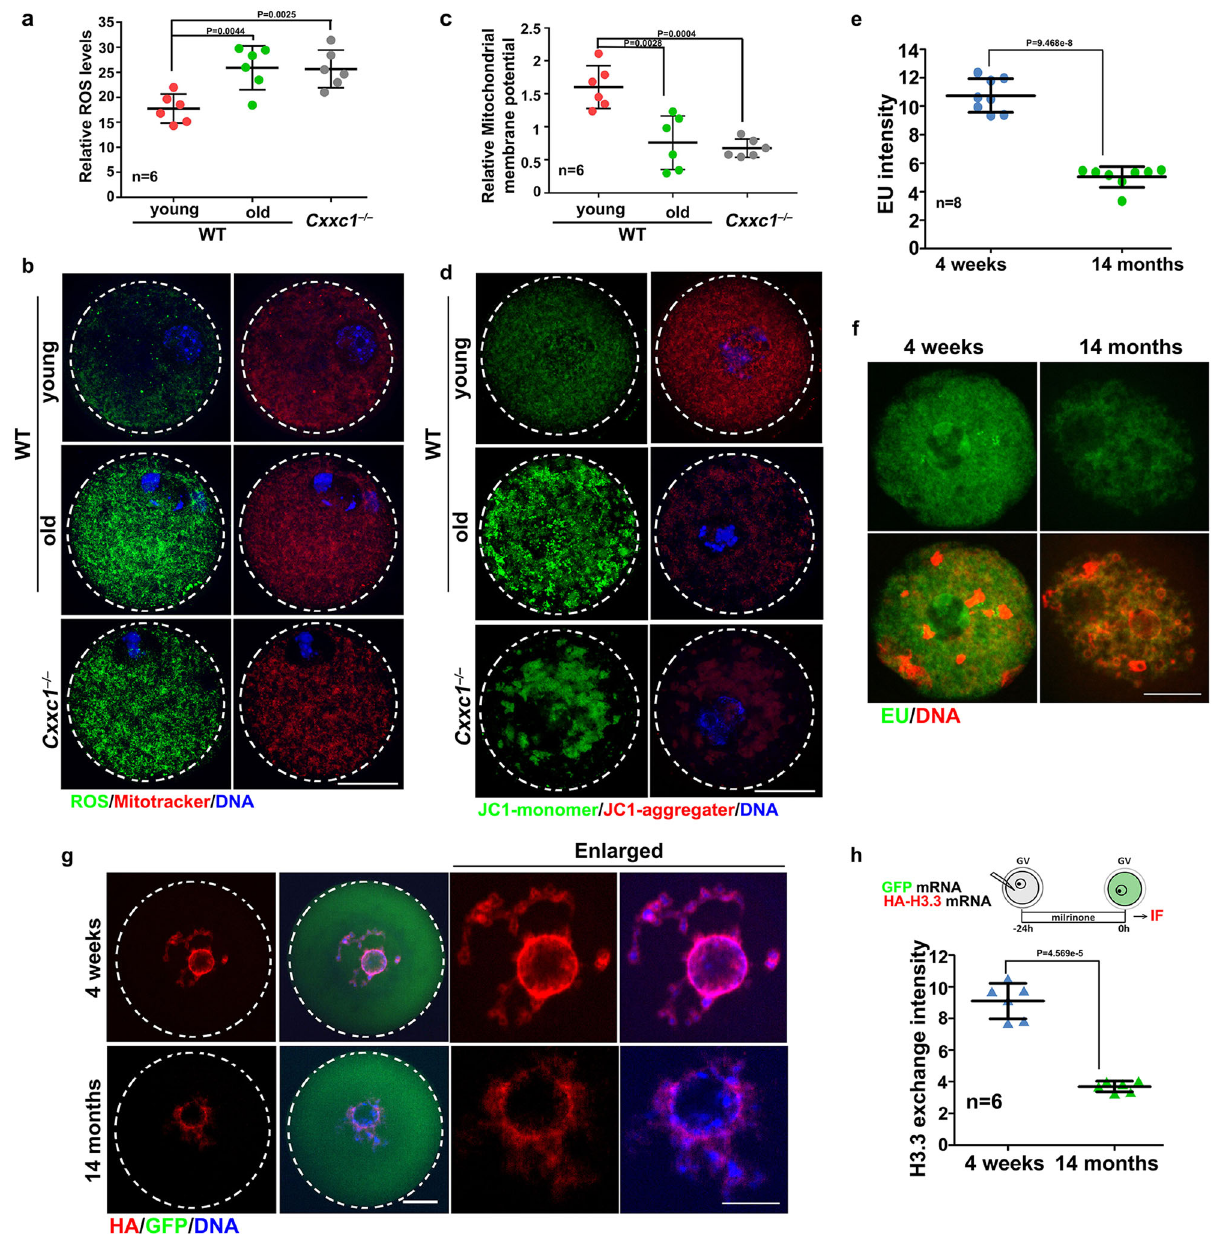
Fig. 5 Aging-associated cytoplasmic changes in WT and Cxxc1 -deleted oocytes. a Detection of reactive oxygen species (ROS) in WT and Cxxc1 -deleted oocytes after in vitro maturation culture. Mitochondria were stained with MitoTracker. Scale bar = 20 µ m for all panels. b Quanti fi cation of ROS signals in ( a ). n = 6 oocytes per experimental group. c JC1 staining in WT and Cxxc1 -deleted oocytes. Scale bar = 20 µ m for all panels. d Mitochondrial membrane potential (MMP) in oocytes isolated from mice of the indicated genotypes, according to JC-1 staining in ( c ). n = 6 oocytes per experimental group. e Detection of newly synthesized RNA by 5-ethynyl uridine (EU) incorporation in growing oocytes with non-surrounded nucleolus derived from 4-week and 14-month mice. Only the nuclei of oocytes are displayed. Scale bar = 10 µ m for all panels. f Quanti fi cation of EU signals ( e ). n = 8 oocytes for each experimental group. g Oocytes were subjected to mRNA microinjection of HA-tagged histone H3.3. An mRNA encoding GFP was co-injected as a positive control for microinjection and expression. The incorporation of histone variants was visualized using anti-HA antibody staining. Scale bar = 10 µ m for all panels. h Quanti fi cation of chromatin-incorporated HA-histone H3.3 signals in ( g ). n = 6 oocytes for each experimental group. In a, b , e , and h , data are presented as mean values ± SEM. P by two-tailed Student ’ s t